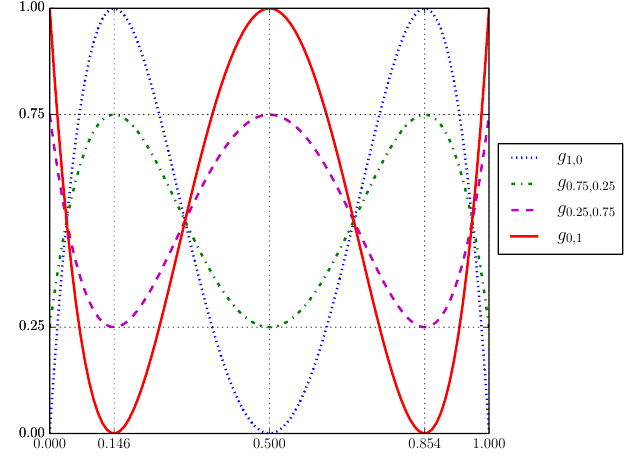
Fig. 5 Graph of the trimodal maps g v